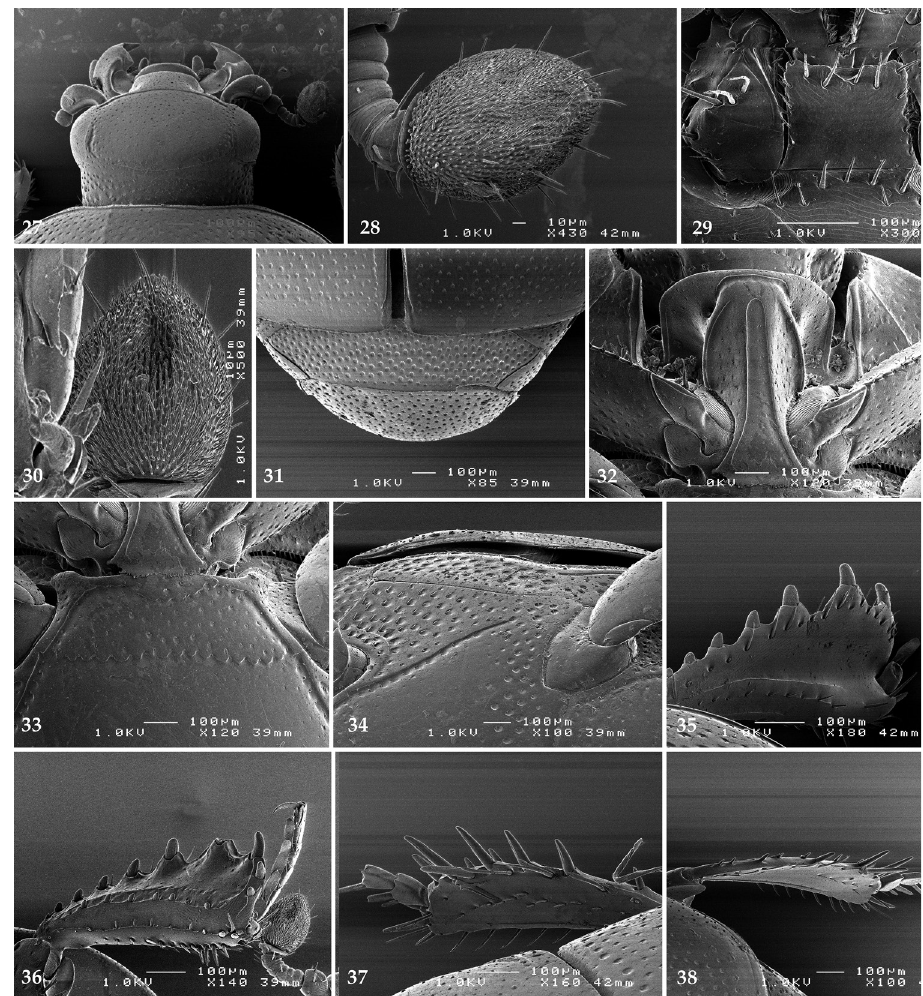
Figures 27–38. 27 Chalcionellus aeneovirens (Schmidt, 1890) head, dorsal view 28 antennal club, dorsal view 29 mentum, ventral view 30 antennal club, ventral view showing sensory structures of the antenna 31 propygydium + pygidium 32 prosternum 33 mesoventrite 34 lateral disc of metaventrite + metepisternum 35 protibia, dorsal view 36 ditto, ventral view 37 mesotibia, dorsal view 38 metatibia, dorsal